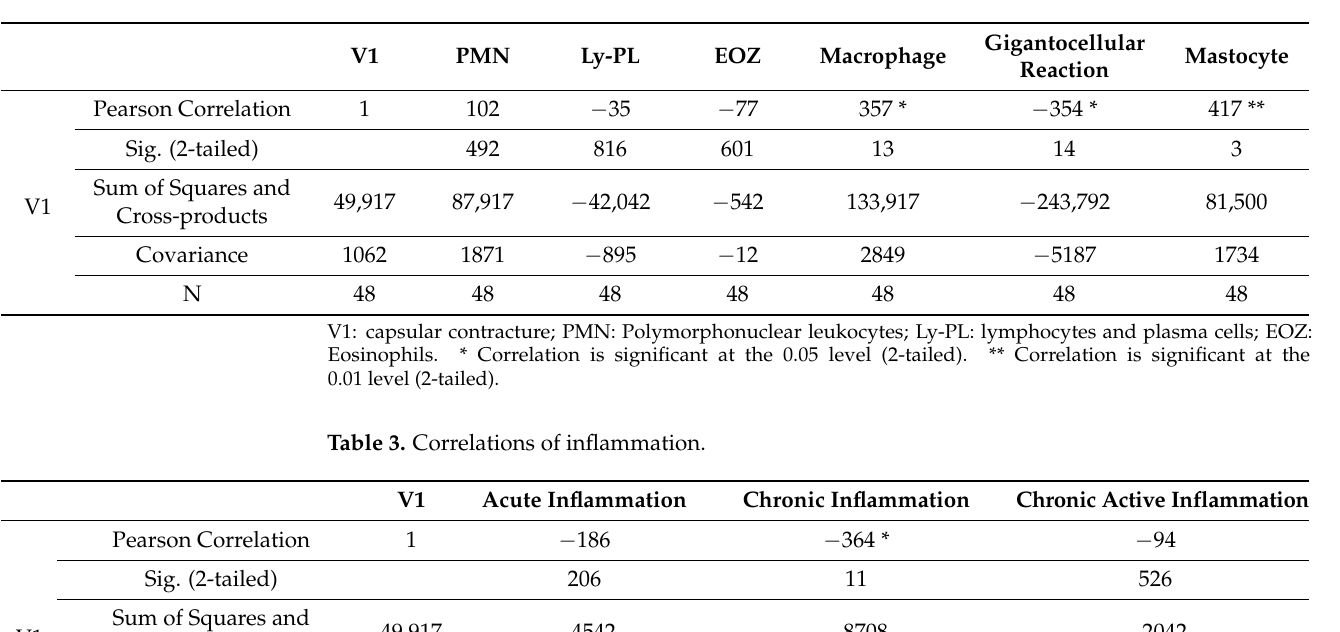
Table 2. Correlations of inflammatory type cells.